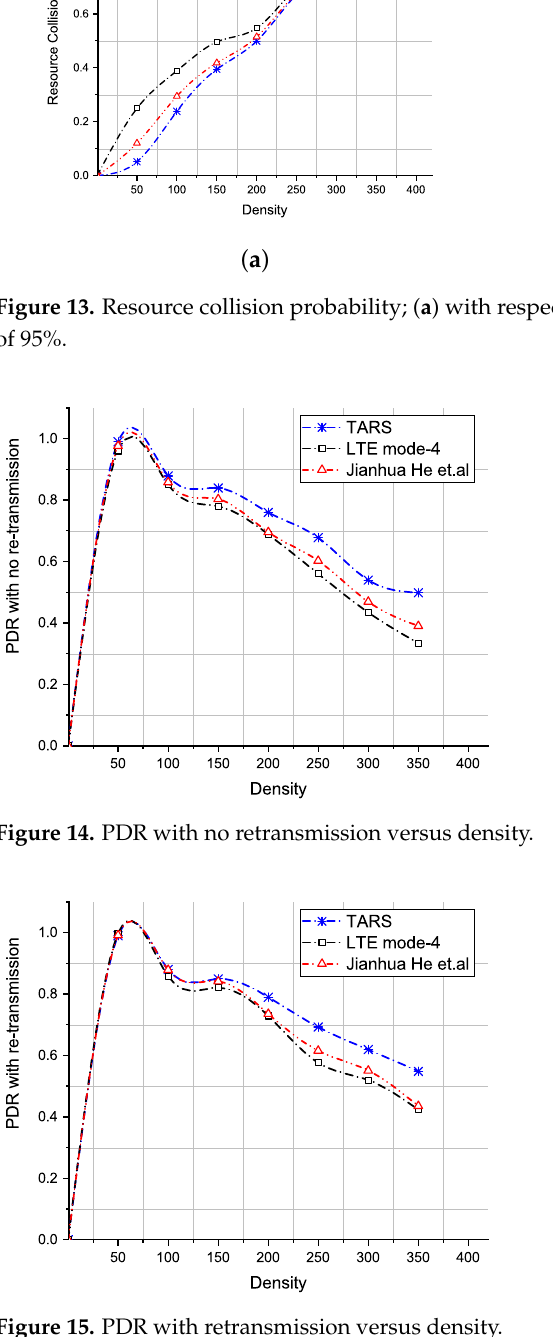
Figure 15. PDR with retransmission versus